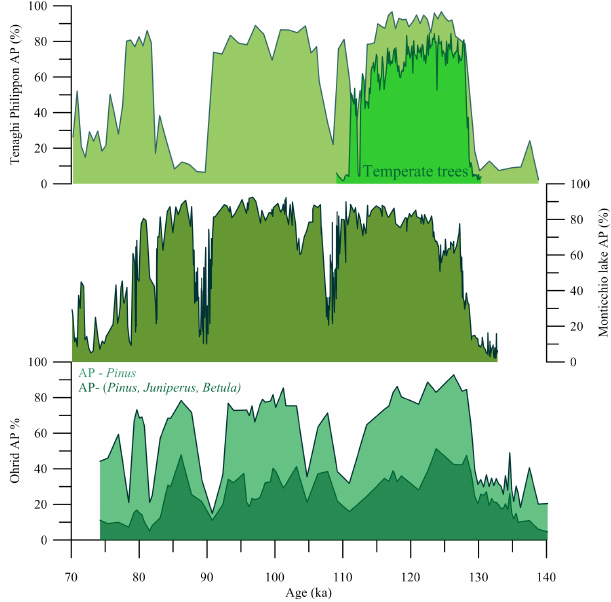
Figure 5. From bottom: DEEP site pollen record (AP- Pinus and AP-( Pinus, Betula and Juniperus ), Sadori et al., 2016) plotted on chronology proposed in this study; Monticchio Lake arboreal pollen (Brauer et al., 2007); Tenaghi Philippon, % of temperate trees from Milner et al. (2012) and total AP from Tzedakis et al.